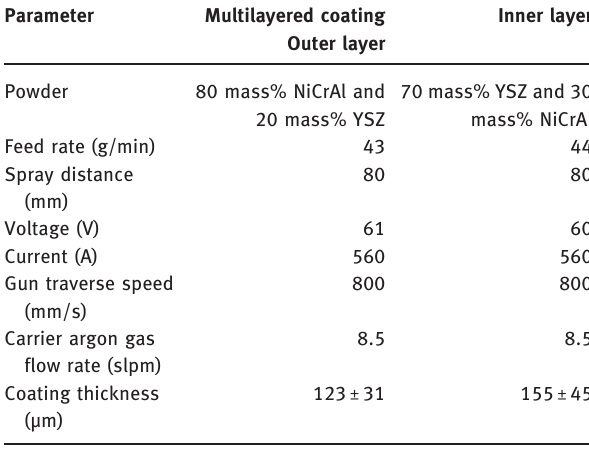
Table 1: Deposition parameters of the tested